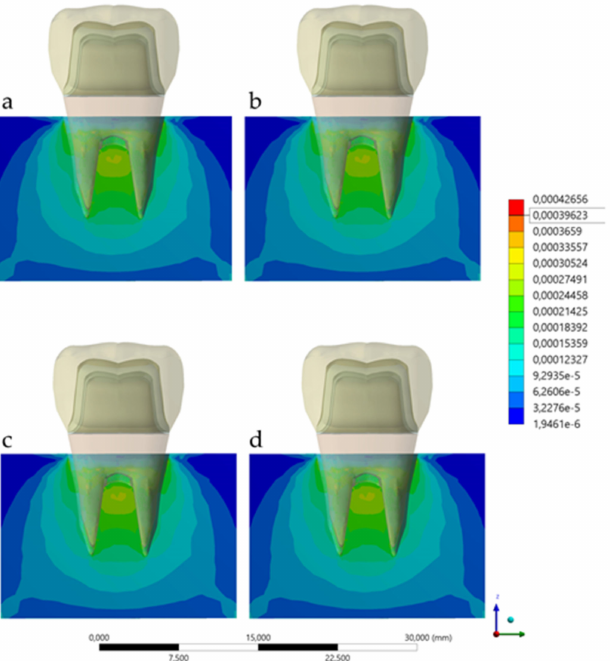
Figure 7. Strain distribution in the bone tissue according to the PC material: ( a ) PEKK; ( b ) Titanium; ( c ) CoCr; and ( d )